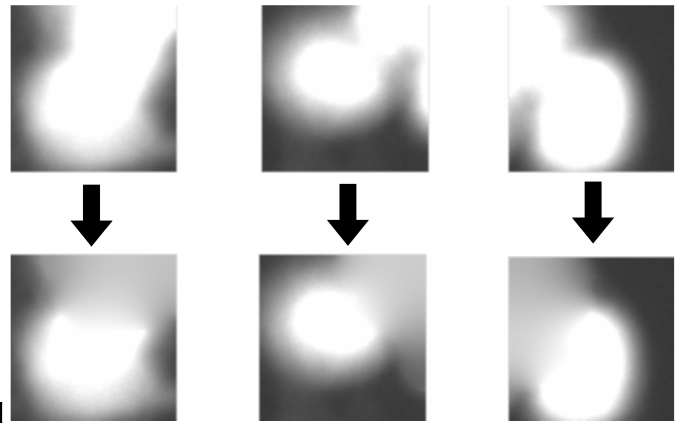
Figure 7. Image borders with fragments of other cells ( top row ) are cleared using watershed transform and inpainting ( bottom row